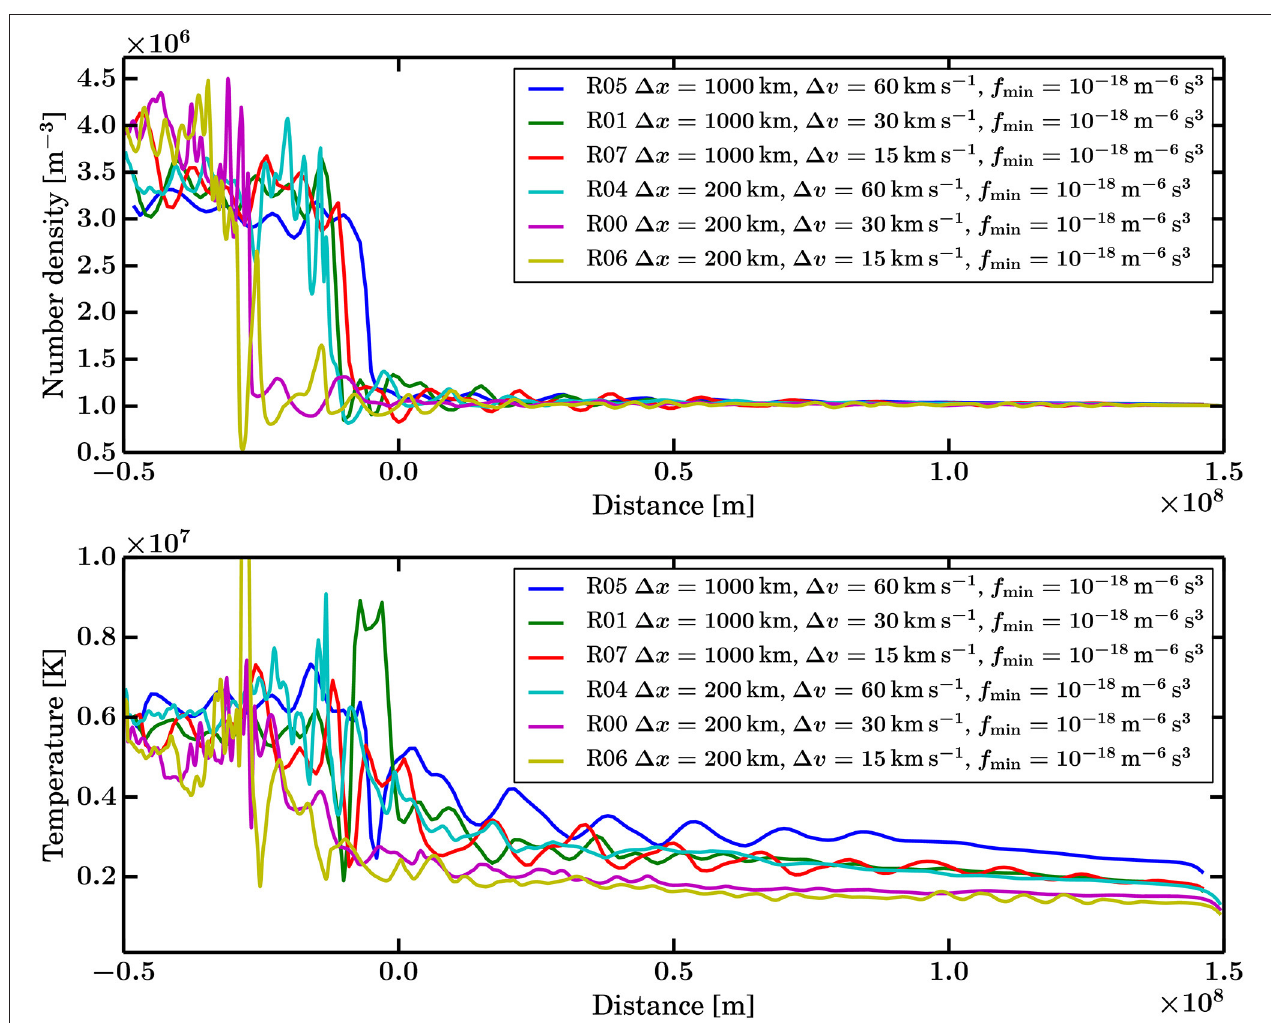
FIGURE 2 | Number density and temperature profiles for Runs R05, R01, R07, R04, R00, and R06 showing the effects of varying 1 x and 1 v .